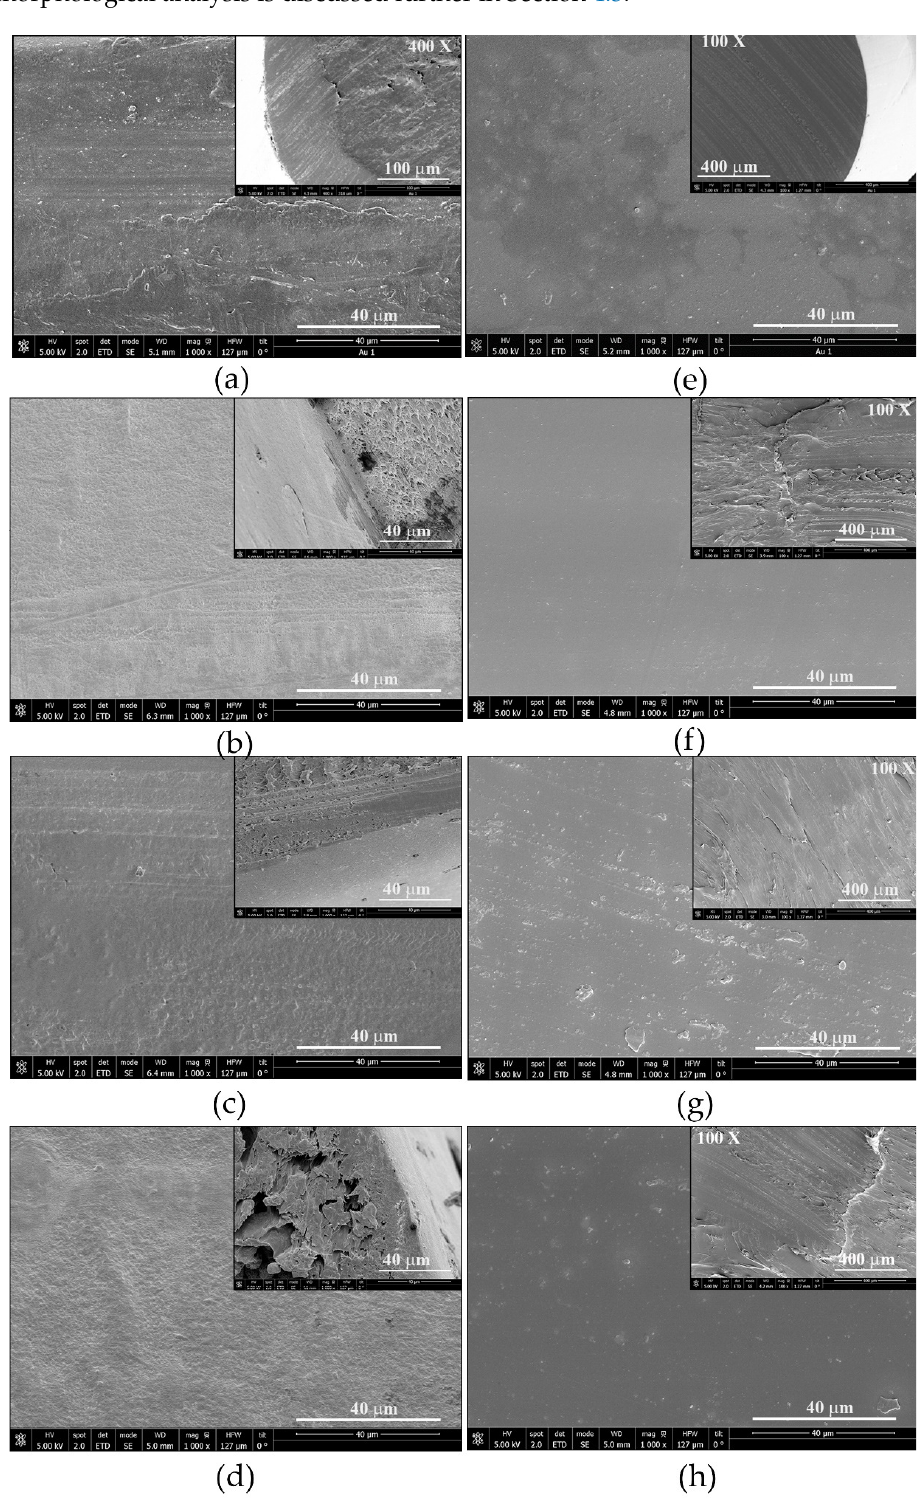
Figure 6. SEM images of longitudinal section of non-treated ( in natura ) filaments: ( a ) PLA and ( e ) TPU, and pressurized filaments of ( b – d ) PLA and ( f – h ) TPU after supercritical treatment with ethanol 3% v / v at 55 ◦ C. ( b , f ) 100 bar; ( c , g ) 250 bar; ( d , h ) 400 bar. The upper right corner images are transversal sections of the polymer filaments. (Magnification × 1000 unless another value is